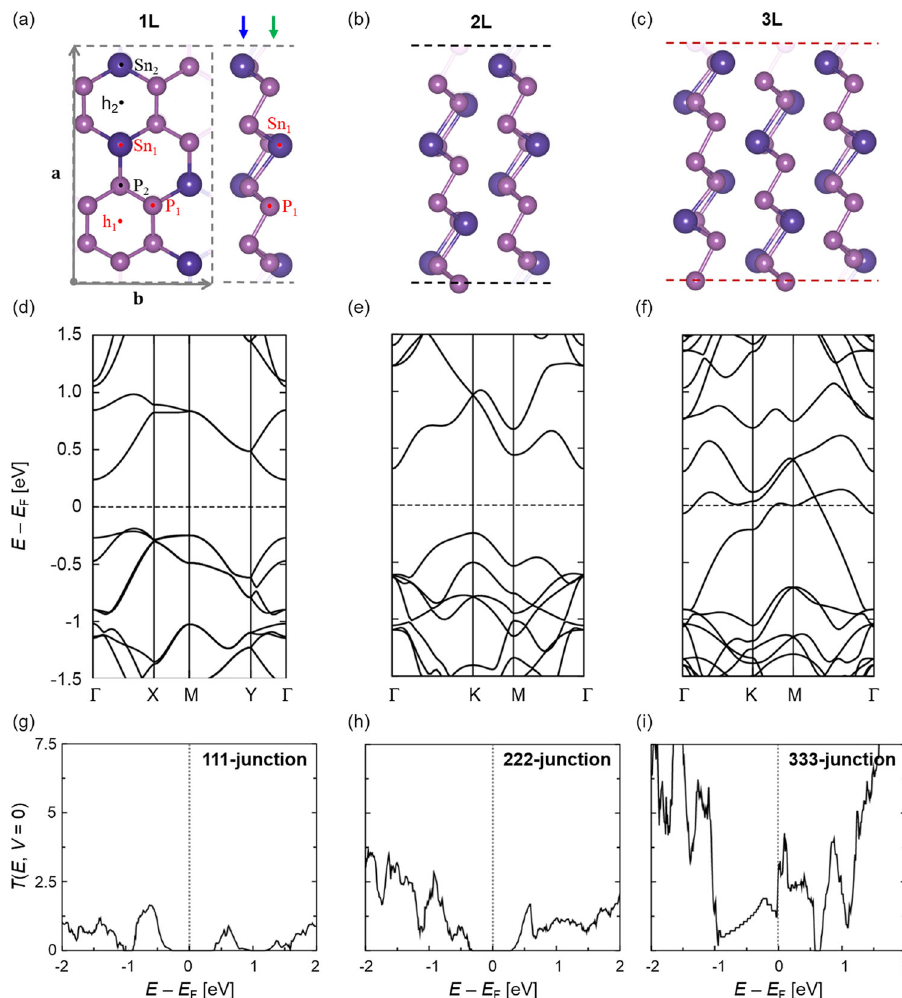
Fig. 1 Crystal structure, electronic band structure, and transport properties of single- and few-layer SnP3. Atomic structures of a 1L, b 2L, and c 3L SnP 3 models in a rectangular unit cell representation with lattice vectors a and b . Each individual layer is composed of two sublayers: upper (green downwards arrow) and lower (blue downwards arrow) layers of Sn and P atoms. h 1 , h 2 , P 1 , P 2 , Sn 1 , and Sn 2 indicate the possible adsorption sites. In the 2L and 3L models, the layers are stacked in the AB and ABC manner, respectively. d – f Corresponding band structures where dashed lines indicate the Fermi levels ( E F ). Intrinsic zero-bias tunnelling probabilities of the pristine g 111, h 222, and i 333 SnP 3 junction models near the Fermi energy level ( E F ). The details for the size of the junctions used to calculate transmission functions are presented in Supplementary Fig. 1. Atom colour code: H – white, C – grey, O – red, N – blue, Sn – purple, and P – light